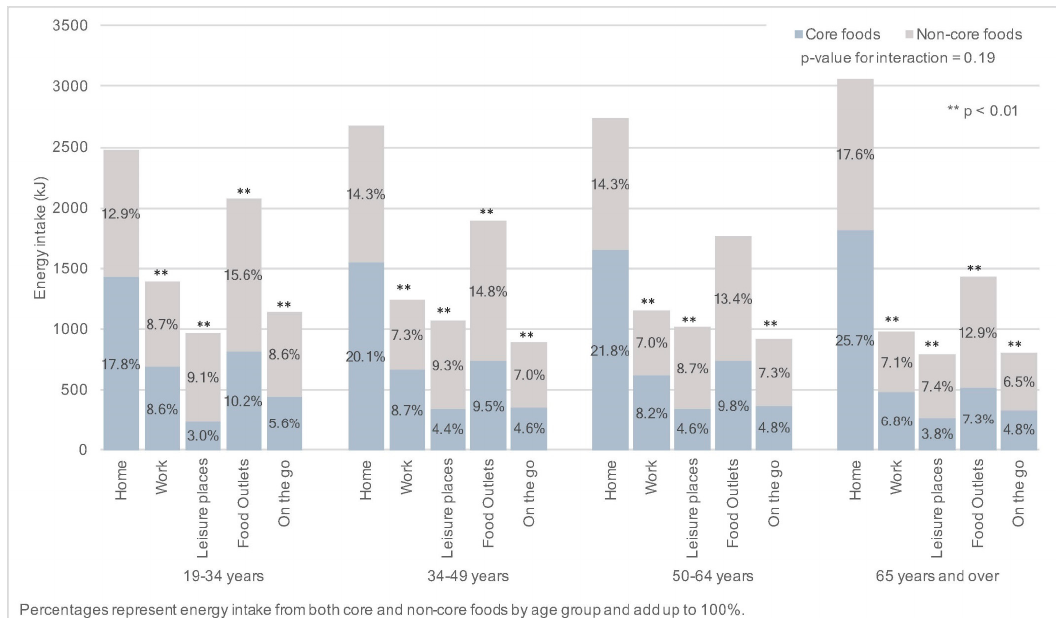
Figure 4. Energy intake (kJ) from core and non-core foods by reported eating location for the NDNS RP Years 1–6 (2008–2014) adult population. Results of logistic regression comparing energy intakes from core and non-core foods by eating location within age group using home as the reference location are presented using